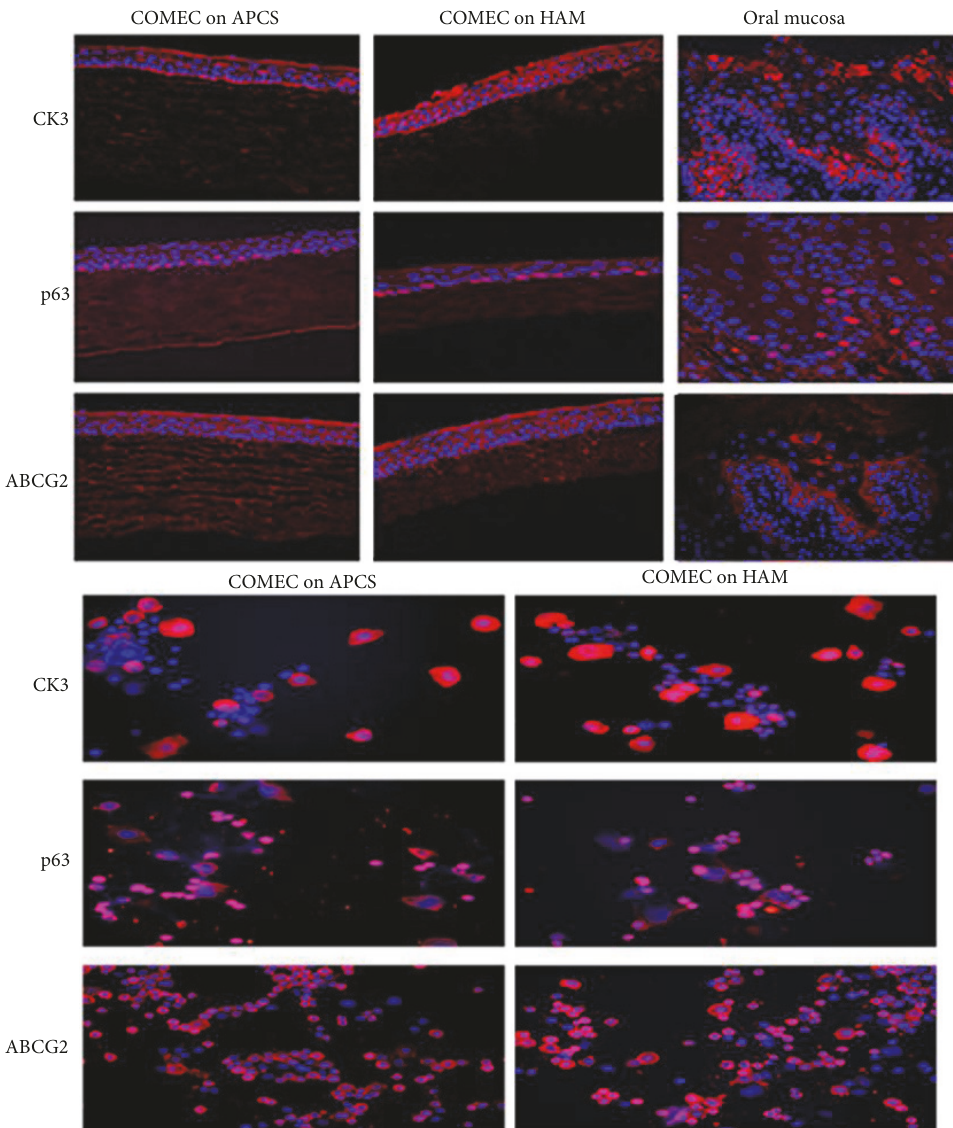
Figure 5: Immunohistochemistry of ex vivo expanded oral epithelium cultured from an explanted culture on either APCS or HAM. Multilayered con fl uent sheet of COMECs appeared after being cultured three to four weeks, which are well attached on APCS and HAM. It shows the expression of p63 in the nuclei of the basal epithelial sheet and ABCG2 and CK3 expression in the cytoplasm in the full- thickness in cultivated oral mucosal epithelial cell sheets both on APCS or HAM. But ABCG2 and p63 are expressed in the basal layer and CK3 is expressed in full-thickness in rat oral mucosal epithelial